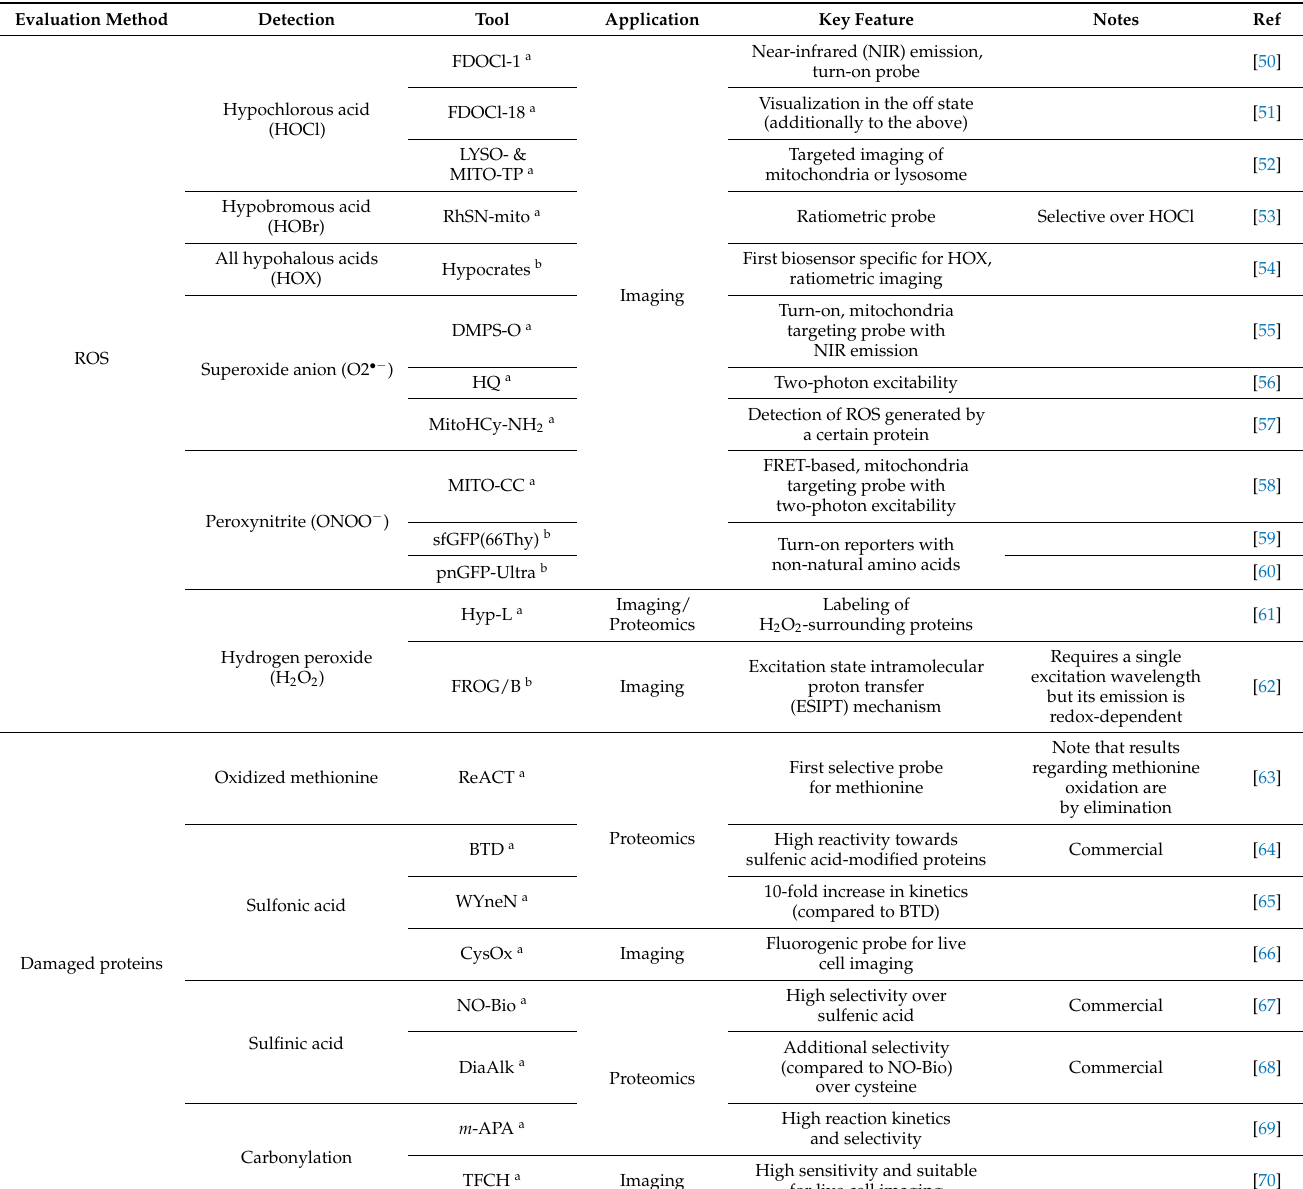
Table 1. Summary of tools reported in Section